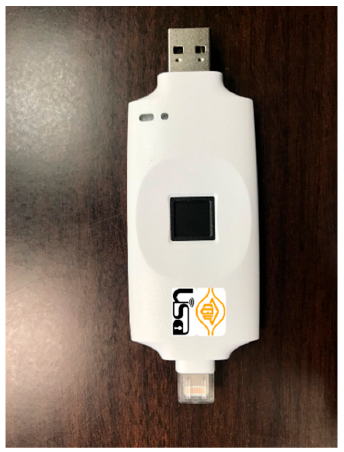
Figure 12. Multi-function smart token.